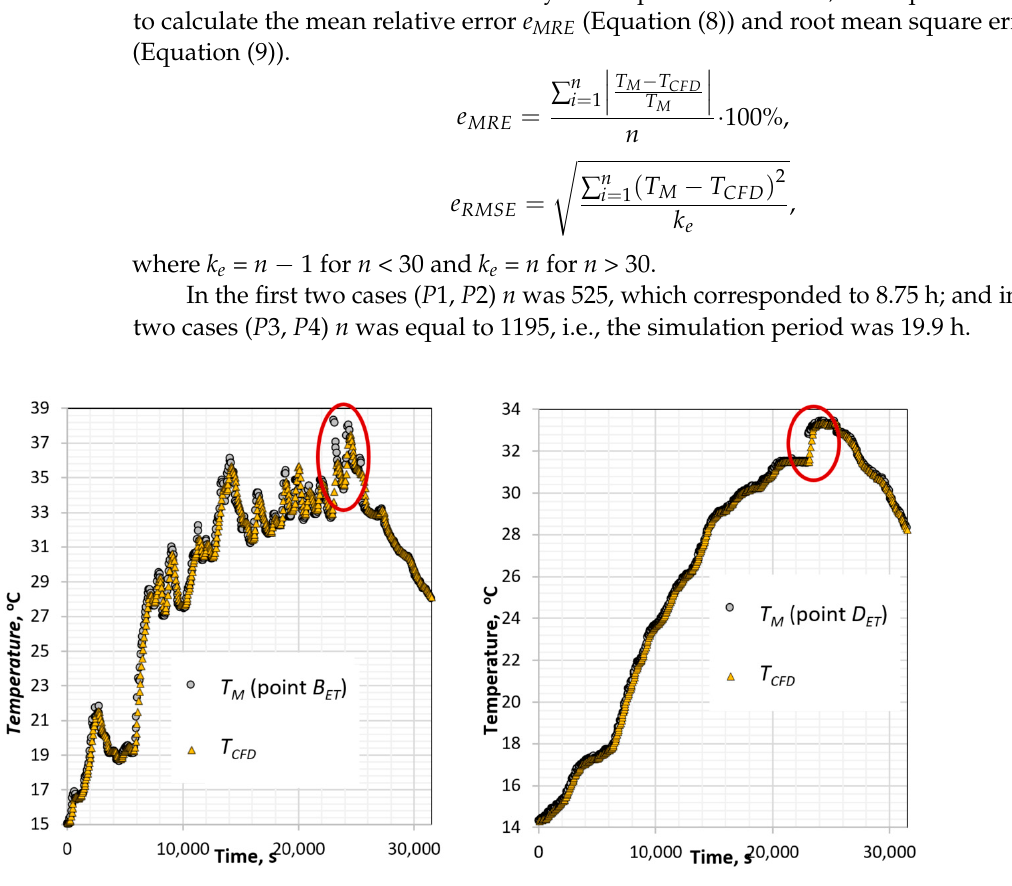
Figure 12. Comparison of the measured and calculated temperature at the outlet from the supply (left side) and return (right side) pipes of the vacuum collectors.